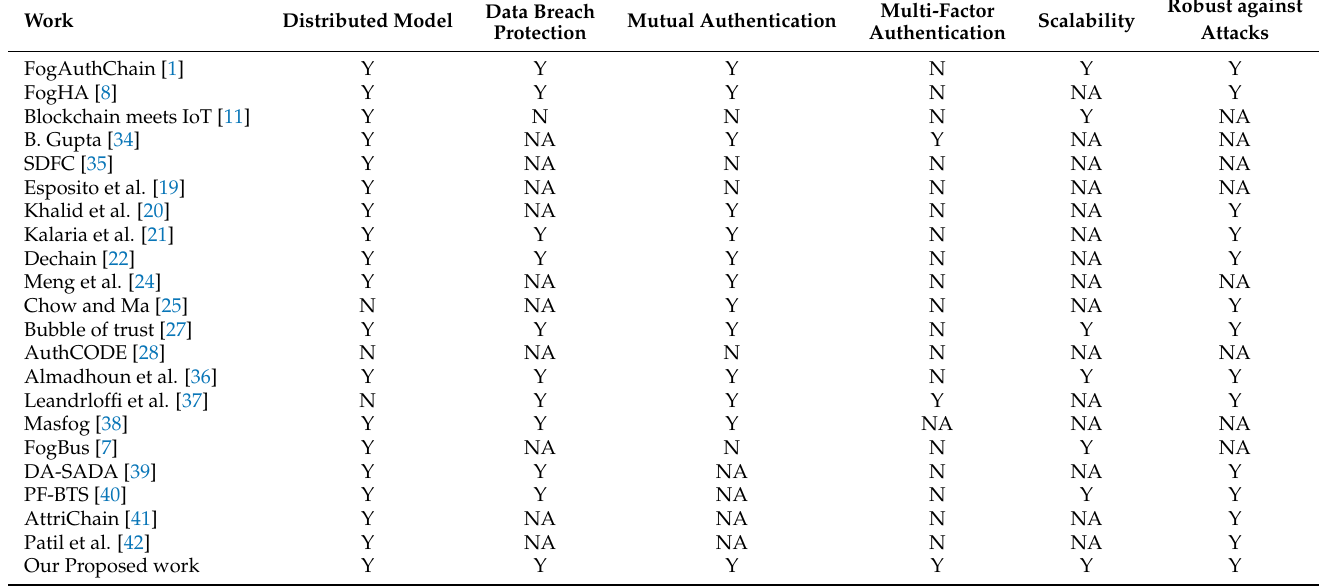
Table 1. Comparative analysis of existing work for decentralised, multi, and mutual authentication whilst considering the scalability and robustness of the authentication systems and frameworks (Y = Yes, N = No, NA = Not Mentioned). (DM = Distributed model, DBP = Data breach protec- tion, Mutual Auth = Mutual authentication, MFA = Multi-factor authentication, S = Scalability, RAA = Robust against